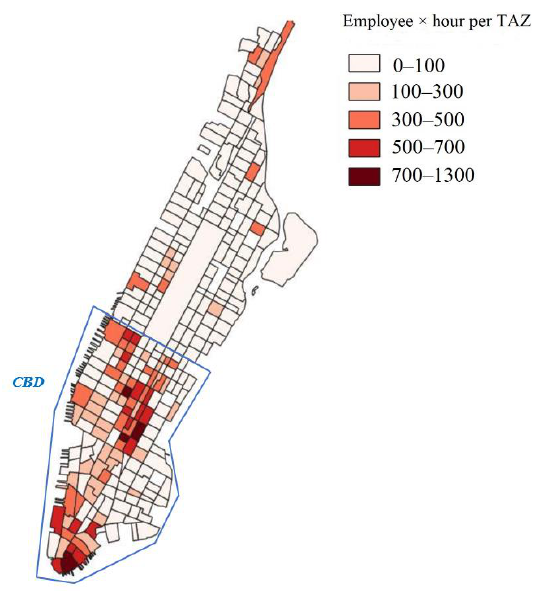
Figure 7. Spatial distribution of employees × hour across the study area.